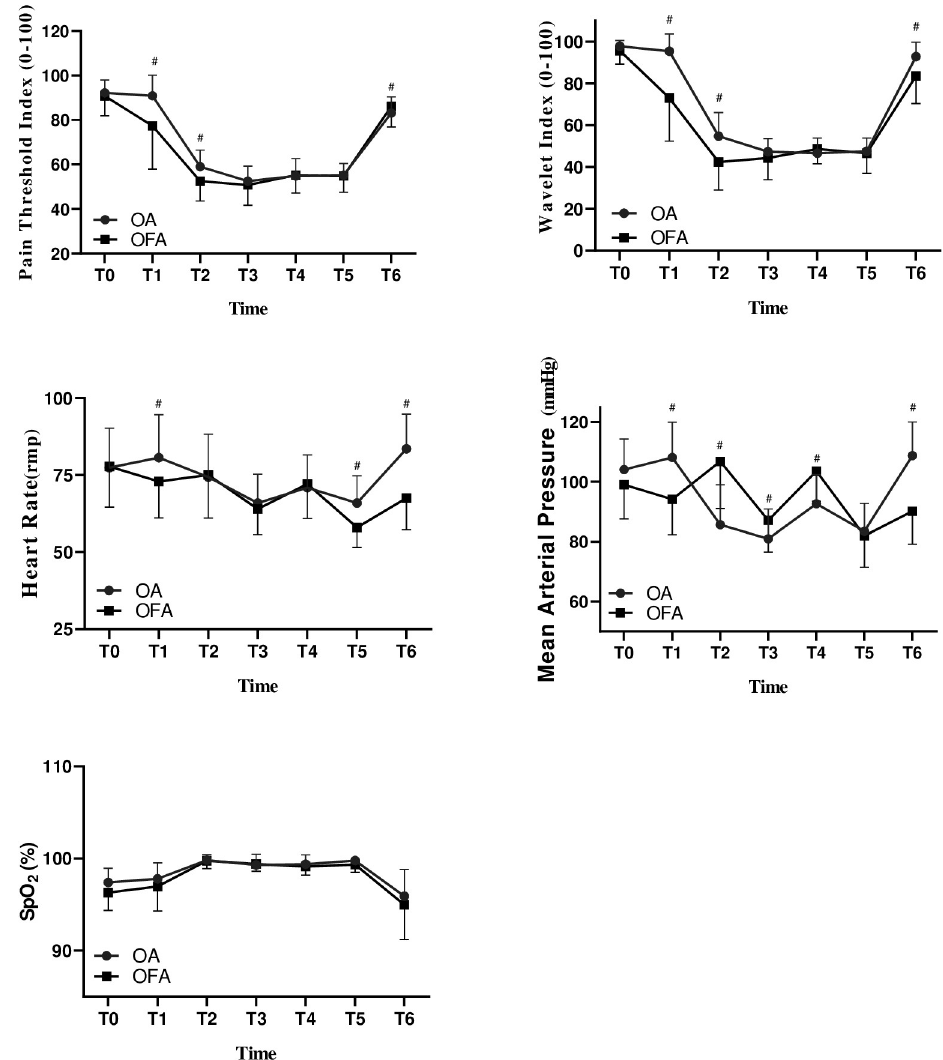
Fig 2. Changes in wavelet index, pain threshold index, mean arterial pressure and heart rate (mean ± SD) between two groups. WLI: wavelet index; PTI: pain threshold index; MAP: mean arterial pressure; HR: heart rate. PTI0: baseline value, PTI1: 10min after dexmedetomidine infusion (1 μ g kg -1 ), PTI2: after intubation, PTI3: 30min after one lung ventilation, PTI4: both lungs ventilation, PTI5: 5 min after extubation. � : p < 0.05 between